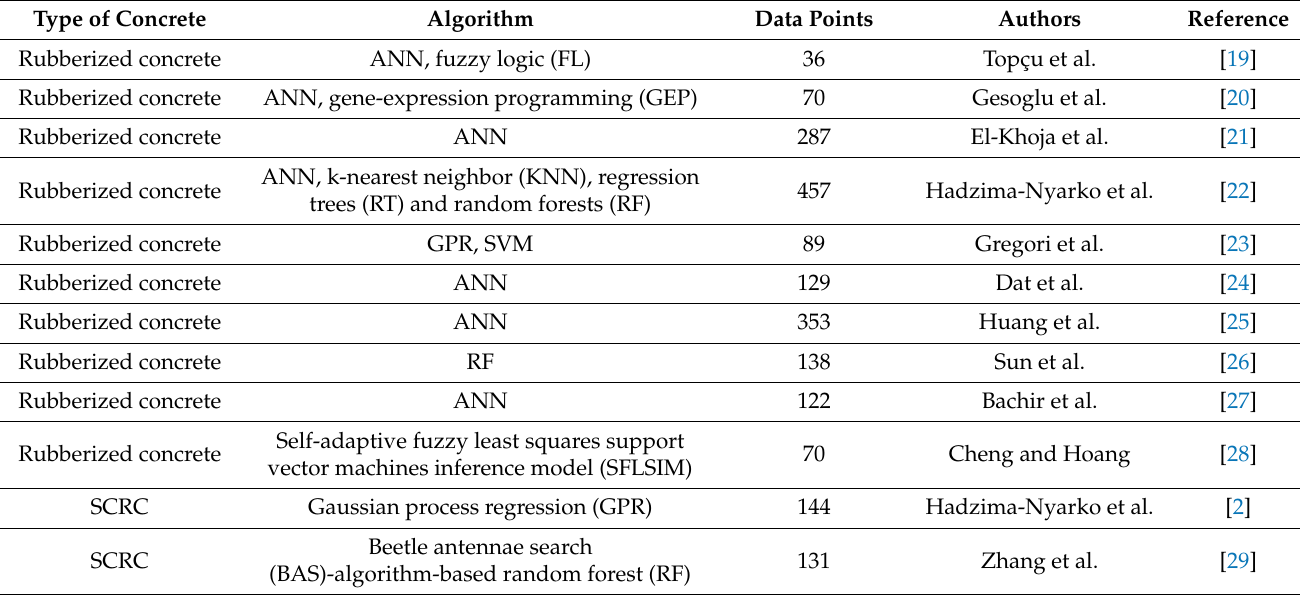
Table 1. Algorithm used in modelling the compressive strength of rubberized concrete and